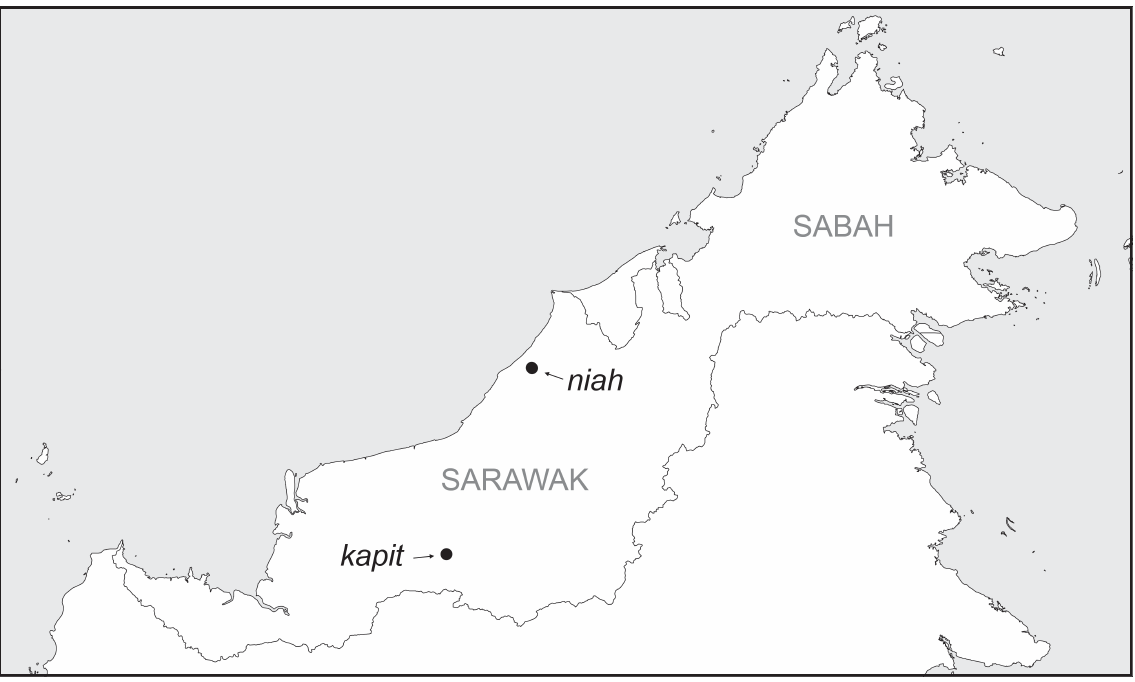
Fig. 7. Map of northern Borneo, showing known records of Hantu